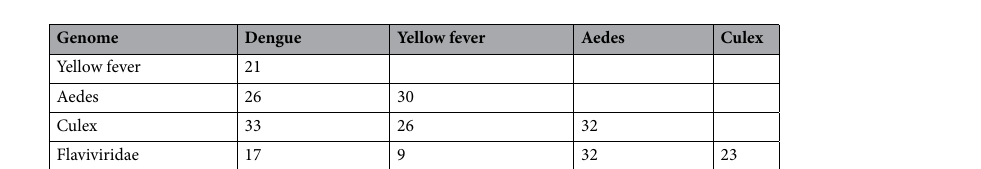
Figure 7. Heatmaps for Homo sapiens (human) and Culicidae (mosquito) ( A and D ), Dengue and Yellow fever viruses ( B and C ), and insect specific Aedes and Culex flaviviruses ( E and F ). Features of the heatmaps are described in the “Methods” section. Black boxes indicate cells with biases opposite of the expected and with a frequency greater than 1.05 for either observed or expected ratio.